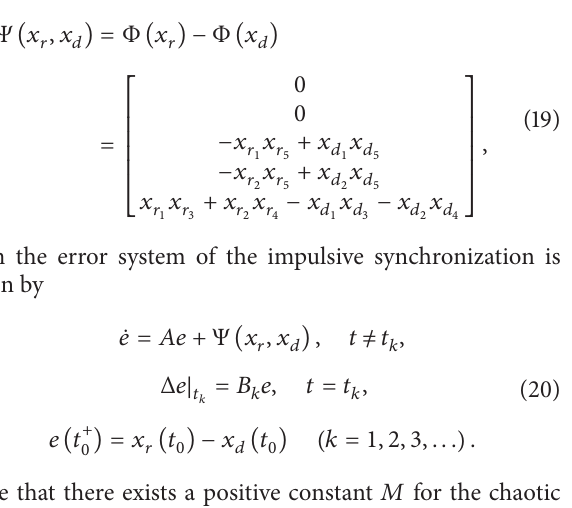
Figure 1: Left figure: Two numerical solutions of (5) for 𝑎 = 14 ; 𝑐 = 35 ; 𝑏 = 3.7 with 𝑡 0 = 0 ; 𝑥 1 (0) = 2 ; 𝑥 2 (0) = 1 ; 𝑥 3 (0) = 5 ; 𝑥 4 (0) = 3 ; (0) = 4 (the solid curve) and ̃𝑥 𝑥 5 Chaotic attractor of (5) at 𝑎 = 14 ; 𝑐 = 35 ; 𝑏 = 3.7 in ( 𝑥 1 ; 𝑥 2 ; 𝑥 5 )